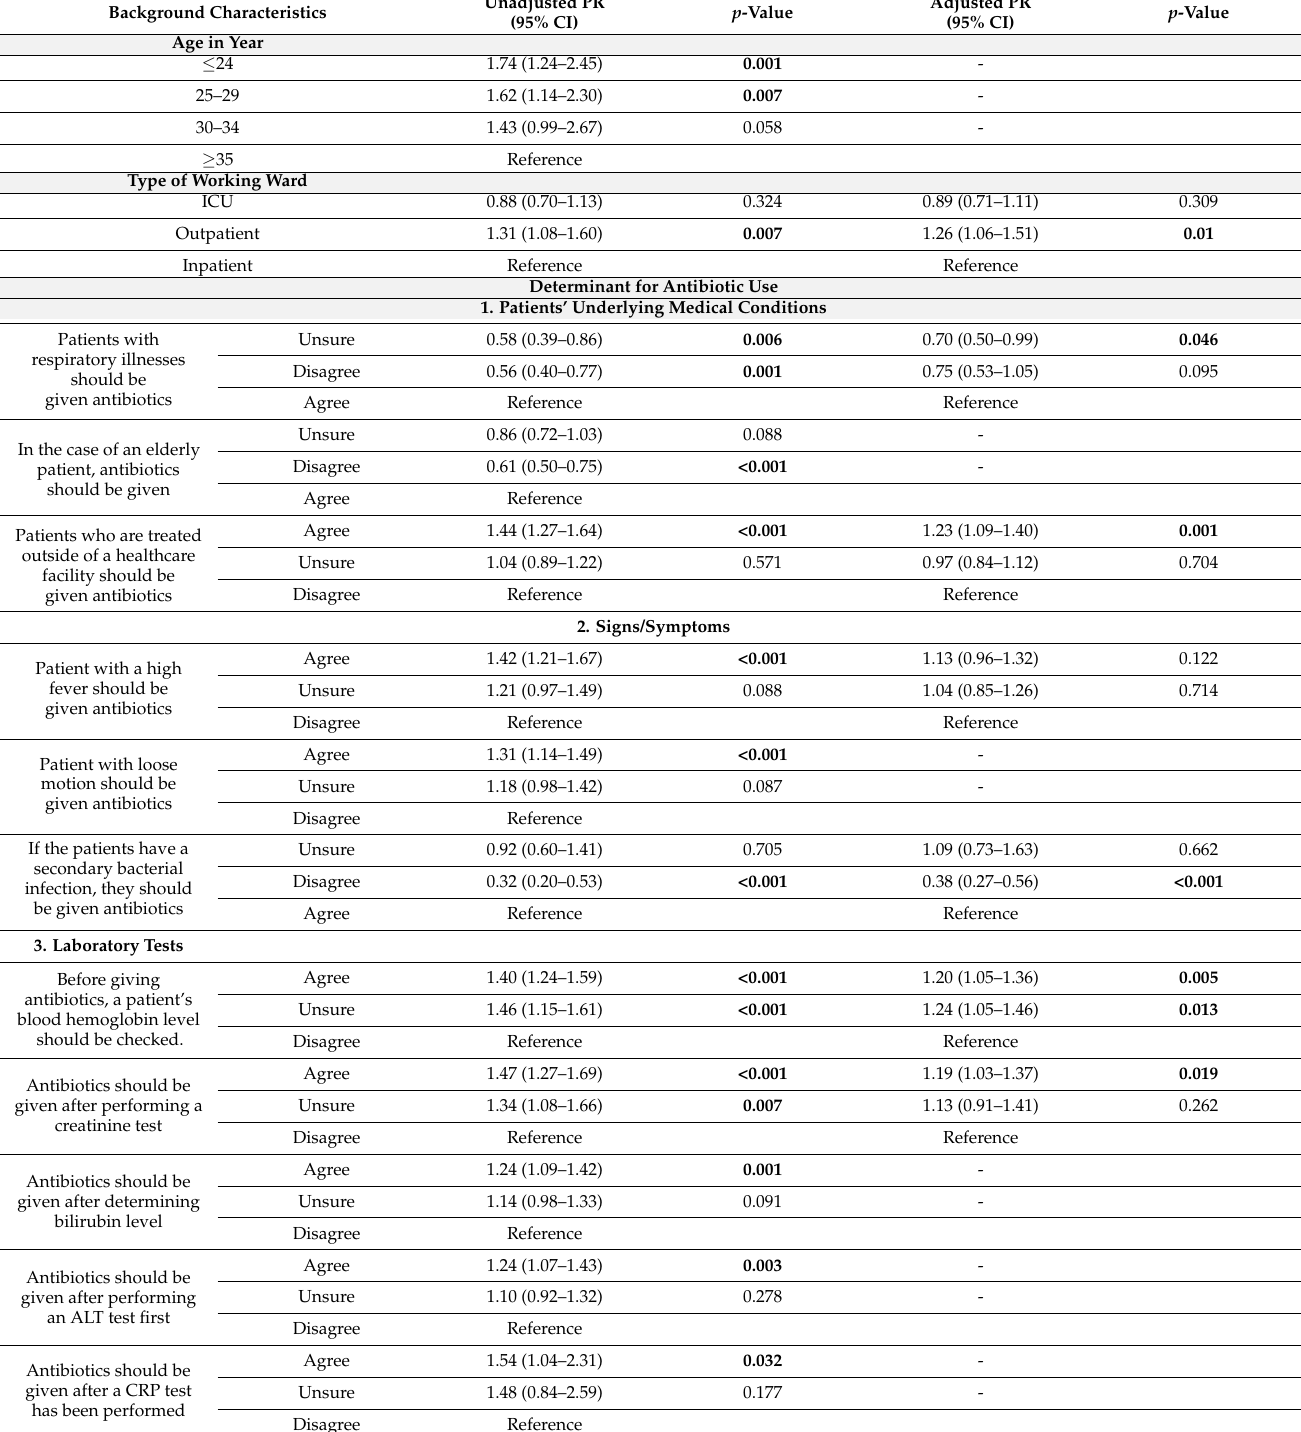
Table 3. Bivariable and multivariable regression analysis to explore factors associated with the overall prevalence of prescribing antibiotics for treating COVID-19